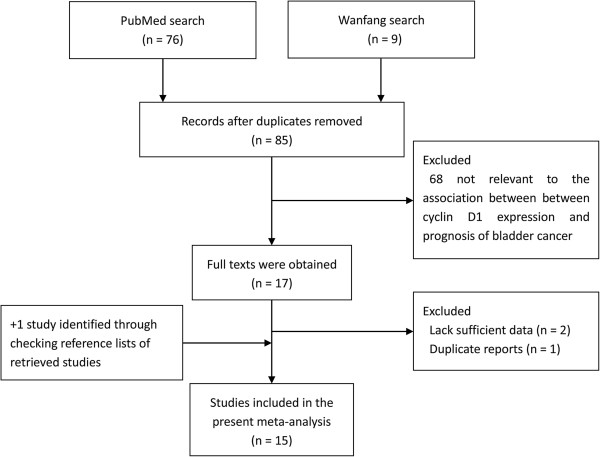
Process of study selection.